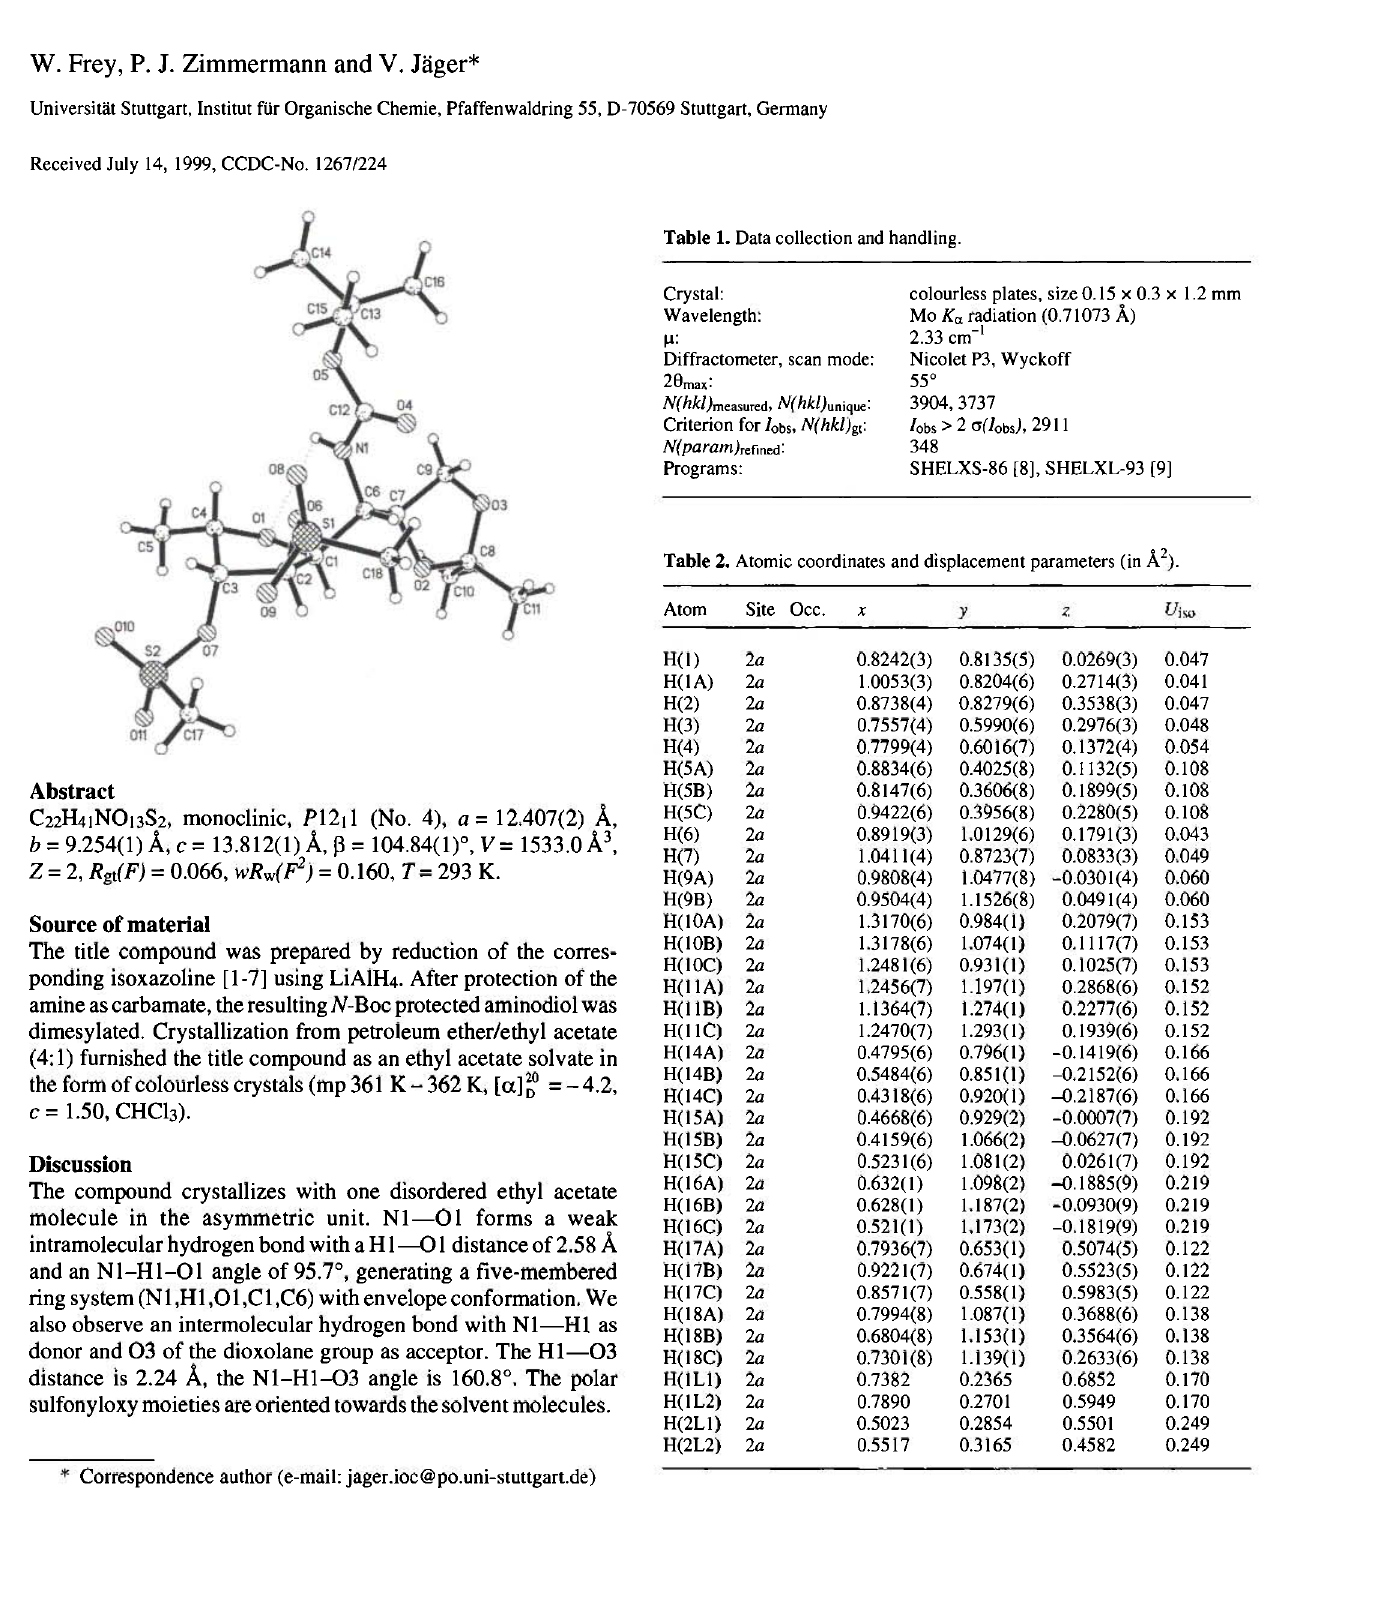
Table 2. Atomic coordinates and displacement parameters (in Ä 2